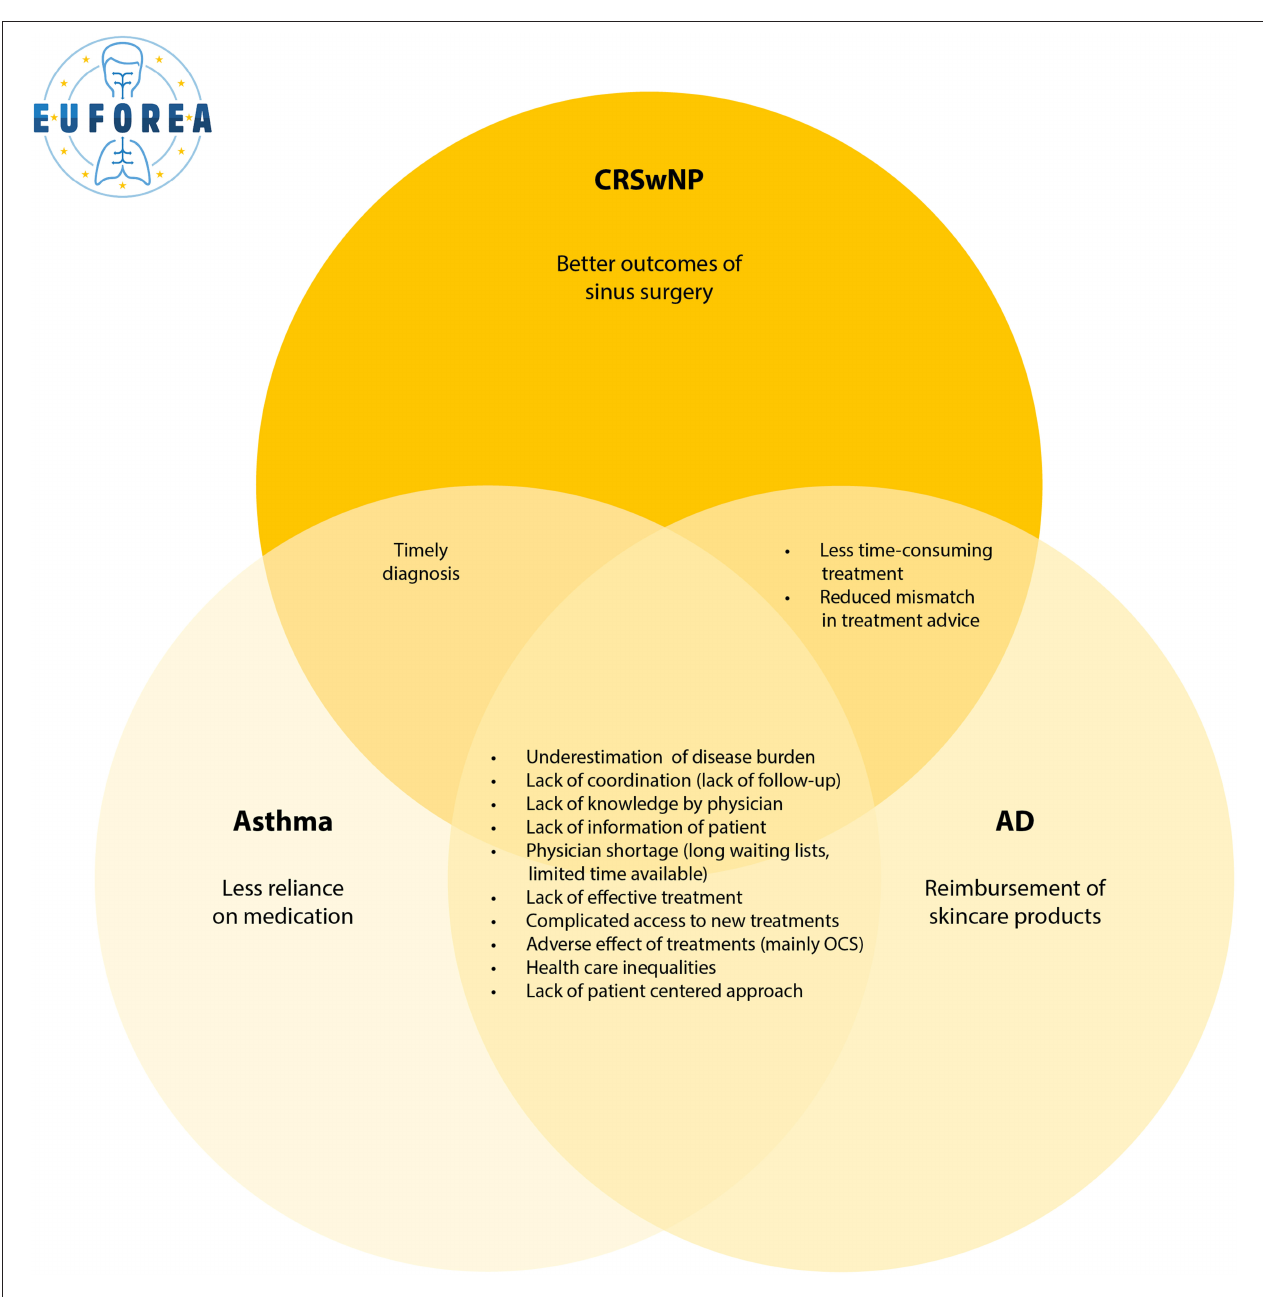
FIGURE 2 | Overview of the perceived unmet needs of current care for patients with Type 2 inflammation, statements ordered by number of times